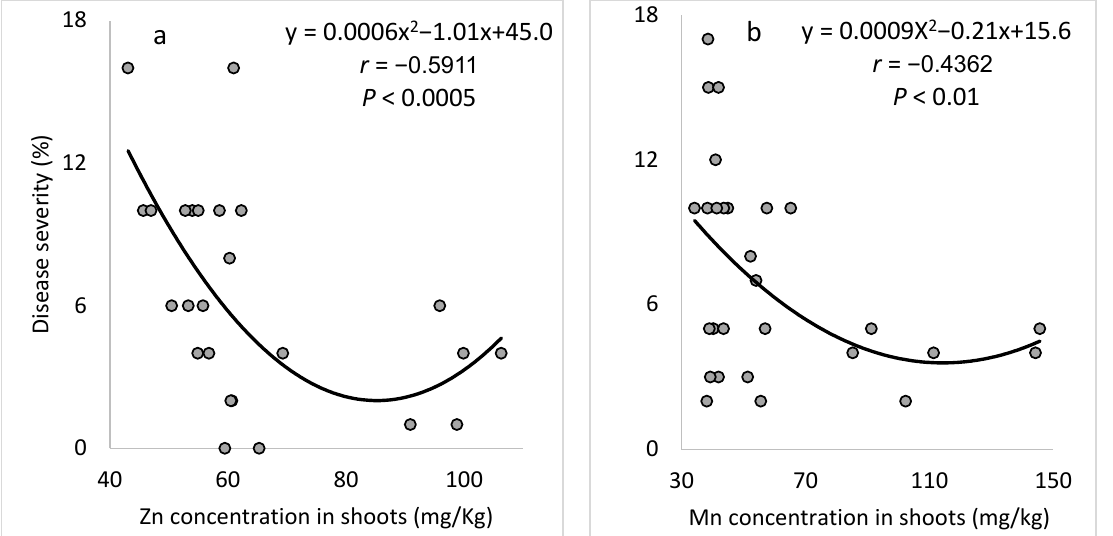
Figure 9. Relationship between the concentrations of microelements ( a ) Zn and ( b ) Mn in the shoots of sweet basil sampled in single plots of Experiment C4 and severity of sweet basil downy mildew (SBDM) at 104 days after planting. SBDM severity was evaluated on a 0 – 100% scale, in which 0 = healthy plants and 100% = plants completely covered by disease symptoms. The best-fit regression formula is presented for each microelement. The Pearson regression values ( r ) are pre- sented along with significance levels ( p ).